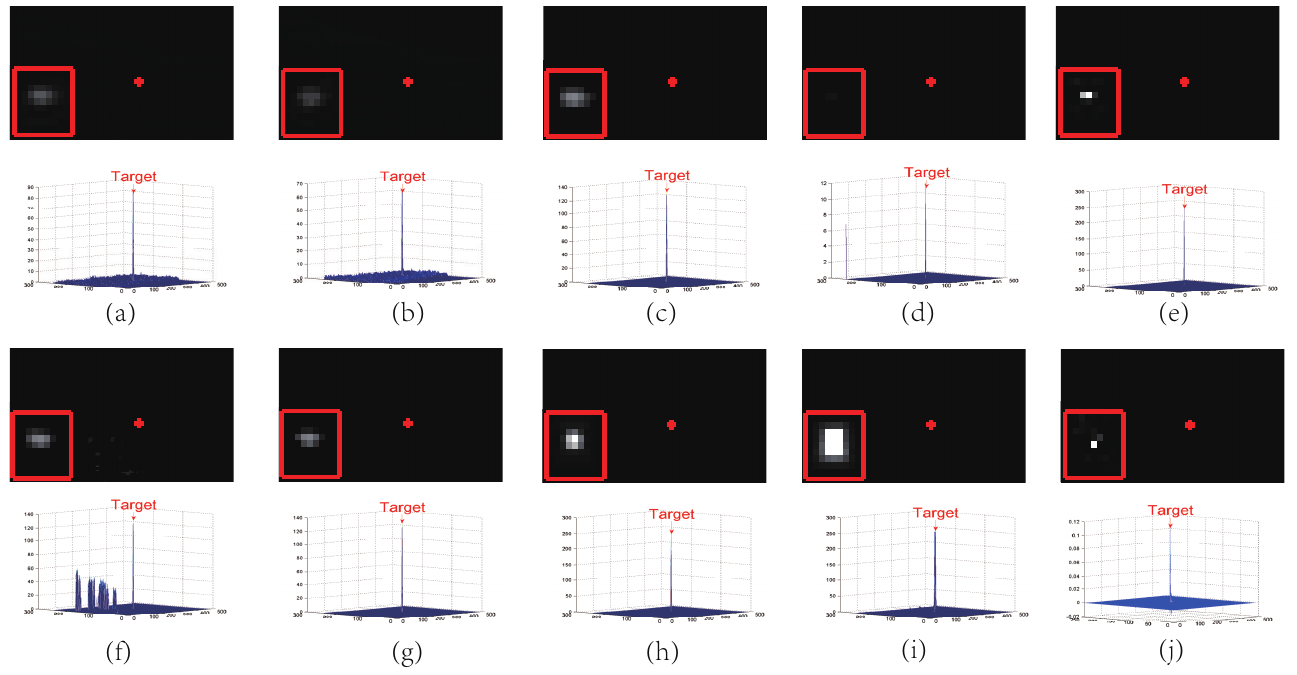
Figure 7. ( a – j ): Top hat, ANI, PSTNN, ASTTV, GST, NTFRA, NRAM, HB-MLCM, ADMD, and the proposed method’s difference diagram and three-dimensional diagram in scene C, respectively.